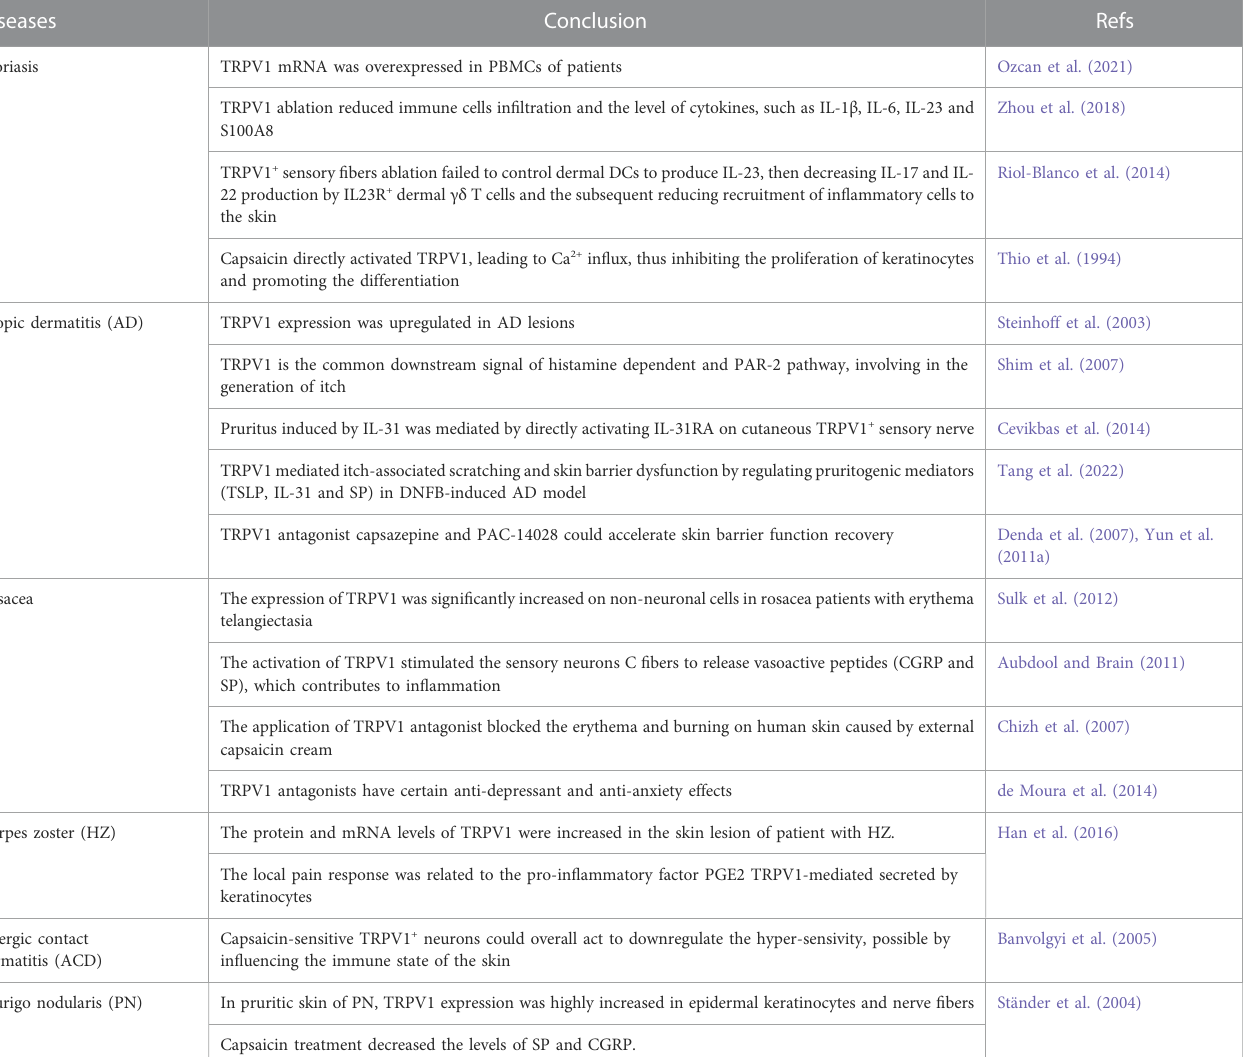
TABLE 1 The role of TRPV1 in in fl ammatory skin